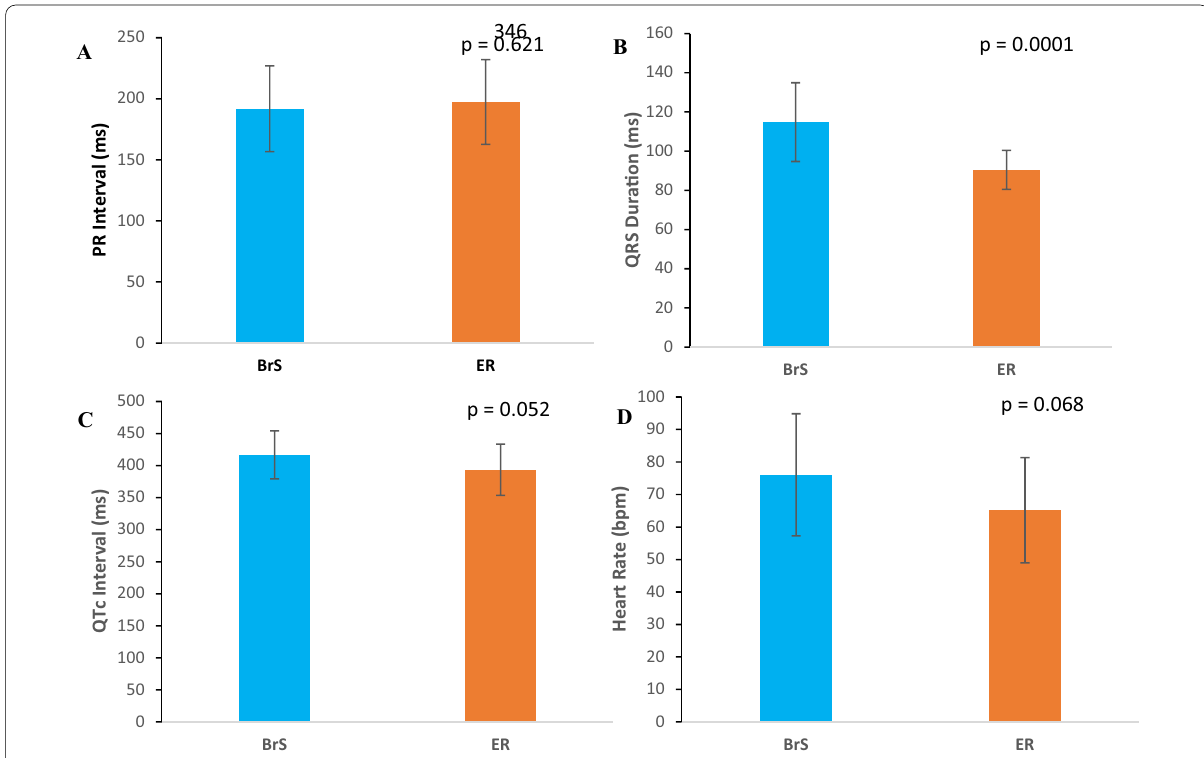
Fig. 2 A PR interval (in milliseconds), B QRS duration (in milliseconds), C QTc interval (in milliseconds) and D resting heart rate (in beats per